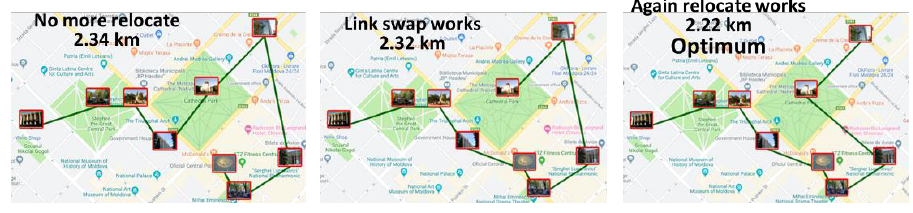
Figure 12. Operators have complementary search spaces.